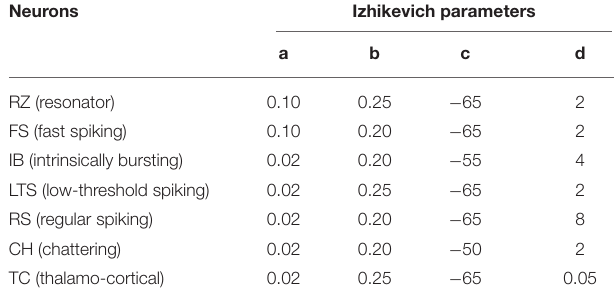
TABLE 1 | Izhikevich models.